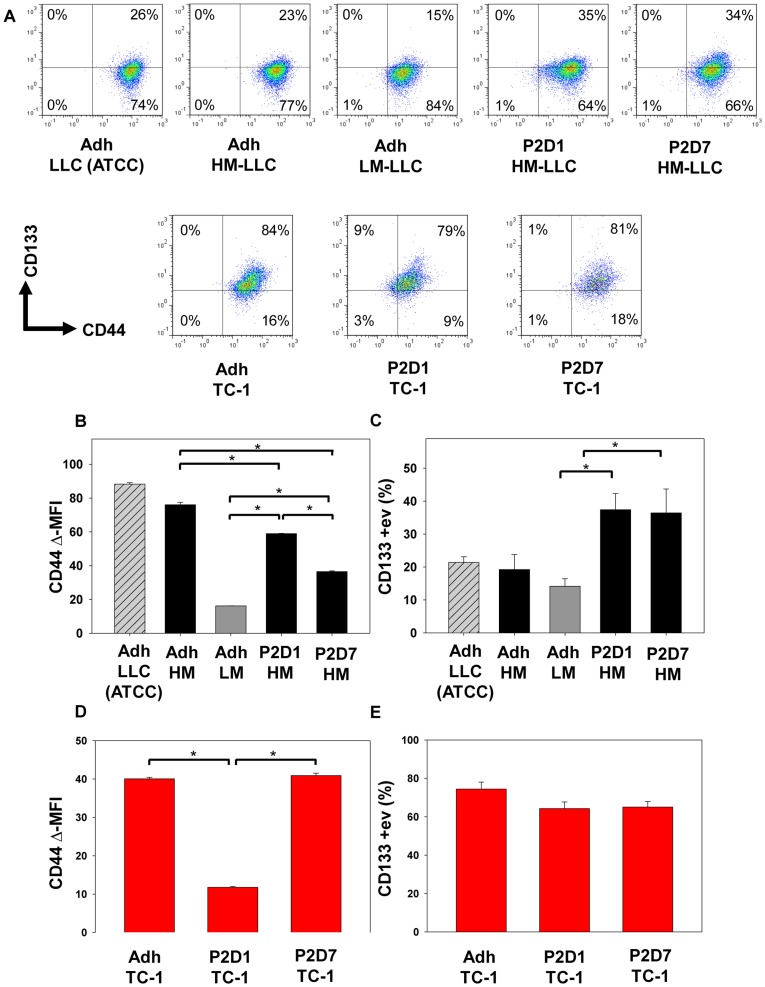
CD133/CD44 cell surface expression.(A) Representative flow cytometry plots for CD133 (Y-axis) and CD44 (X-axis) co-staining. (B and D) The mean fluorescent intensity (MFI) of CD44 is shown corrected for intensity of isotype staining for LLC and TC-1 cells. (B) HM-LLC spheres and adherent cells as well as LLC (ATCC) cells express higher amounts of CD44 compared to LM-LLC cells. Sphere-derived cells were found to have a lower MFI for CD44 compared to HM-LLC adherent cells. D7 sphere-derived cells had a lower MFI for CD44 compared to D1 cells; *P<0.001. (D) Day 1 TC-1 sphere-derived cells express less CD44 than day 7 or adherent cells; *P≤0.002. (C) CD133 frequency of positive cells is higher in HM-LLC spheres compared to LM-LLC adherent cells; *P≤0.043. CD133 expression was not significantly different between HM-LLC adherent cells and spheres or amongst the three different LLC adherent cells. (E) No significant difference in CD133 expression amongst the TC-1 culture conditions. Experiment done in triplicate, representative results shown. Bars: ±SEM.